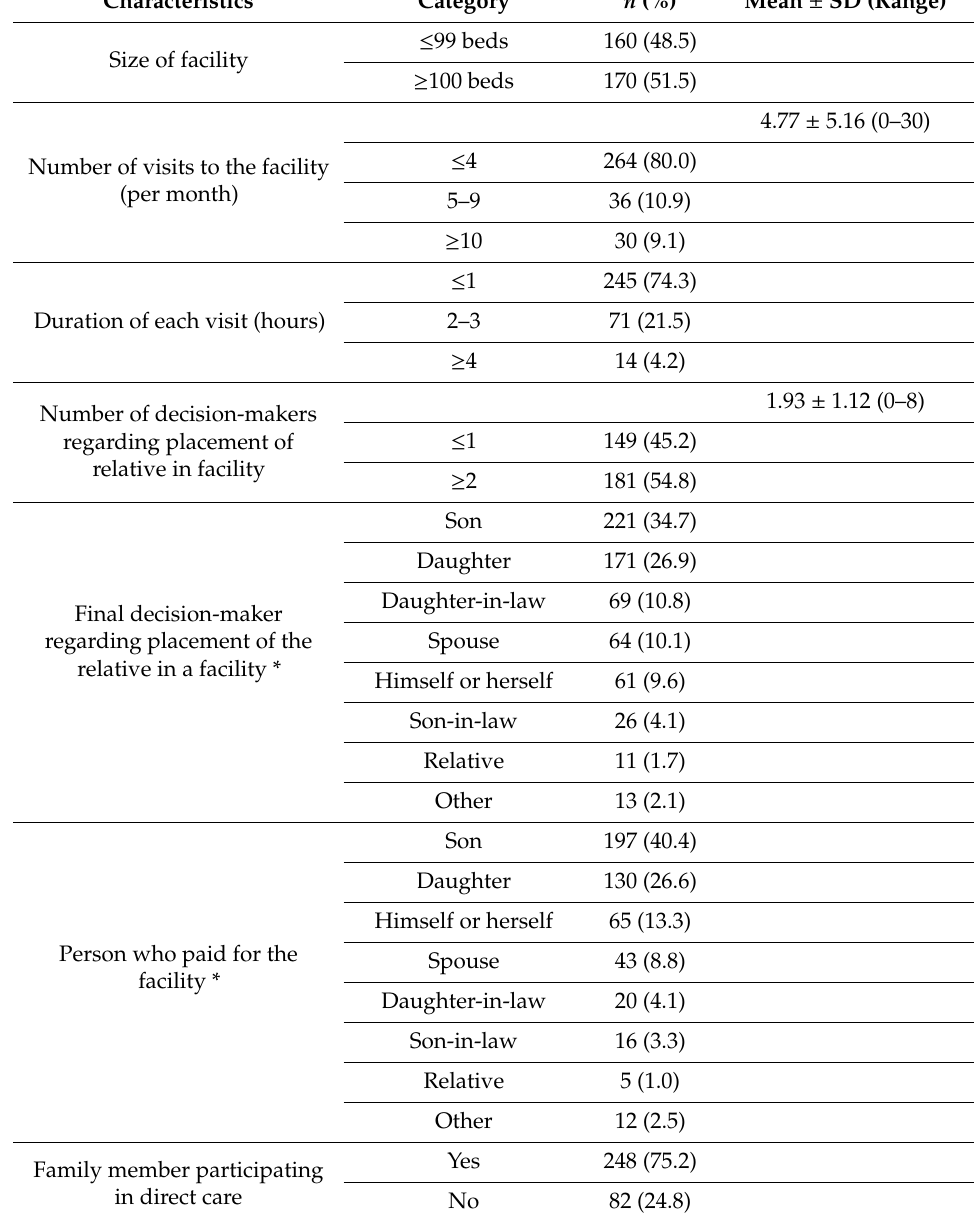
Table 3. Facility care-related characteristics, N =